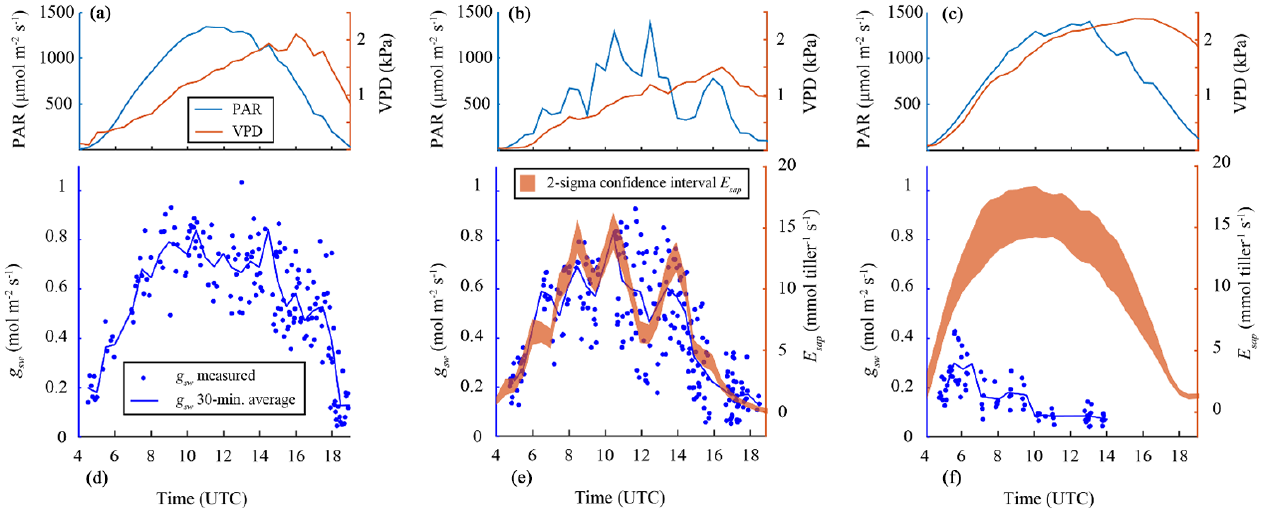
Figure 3. Diurnal changes in photosynthetically active radiation (PAR) and vapour pressure deficit (VPD) measured for (a) IOP 1, (b) IOP 2, and (c) IOP 3. Leaf-level measurements of stomatal conductance of water vapour ( g sw ) in (b) and (c) compared to tiller-level measurements of sap flow ( E sap ). Leaf-level measurements of g sw (blue markers) were averaged over 30min intervals (blue line). Sap flow measurements represent the 1SD confidence interval (shaded region) of measurements on 24 tillers averaged over 30min timescales.